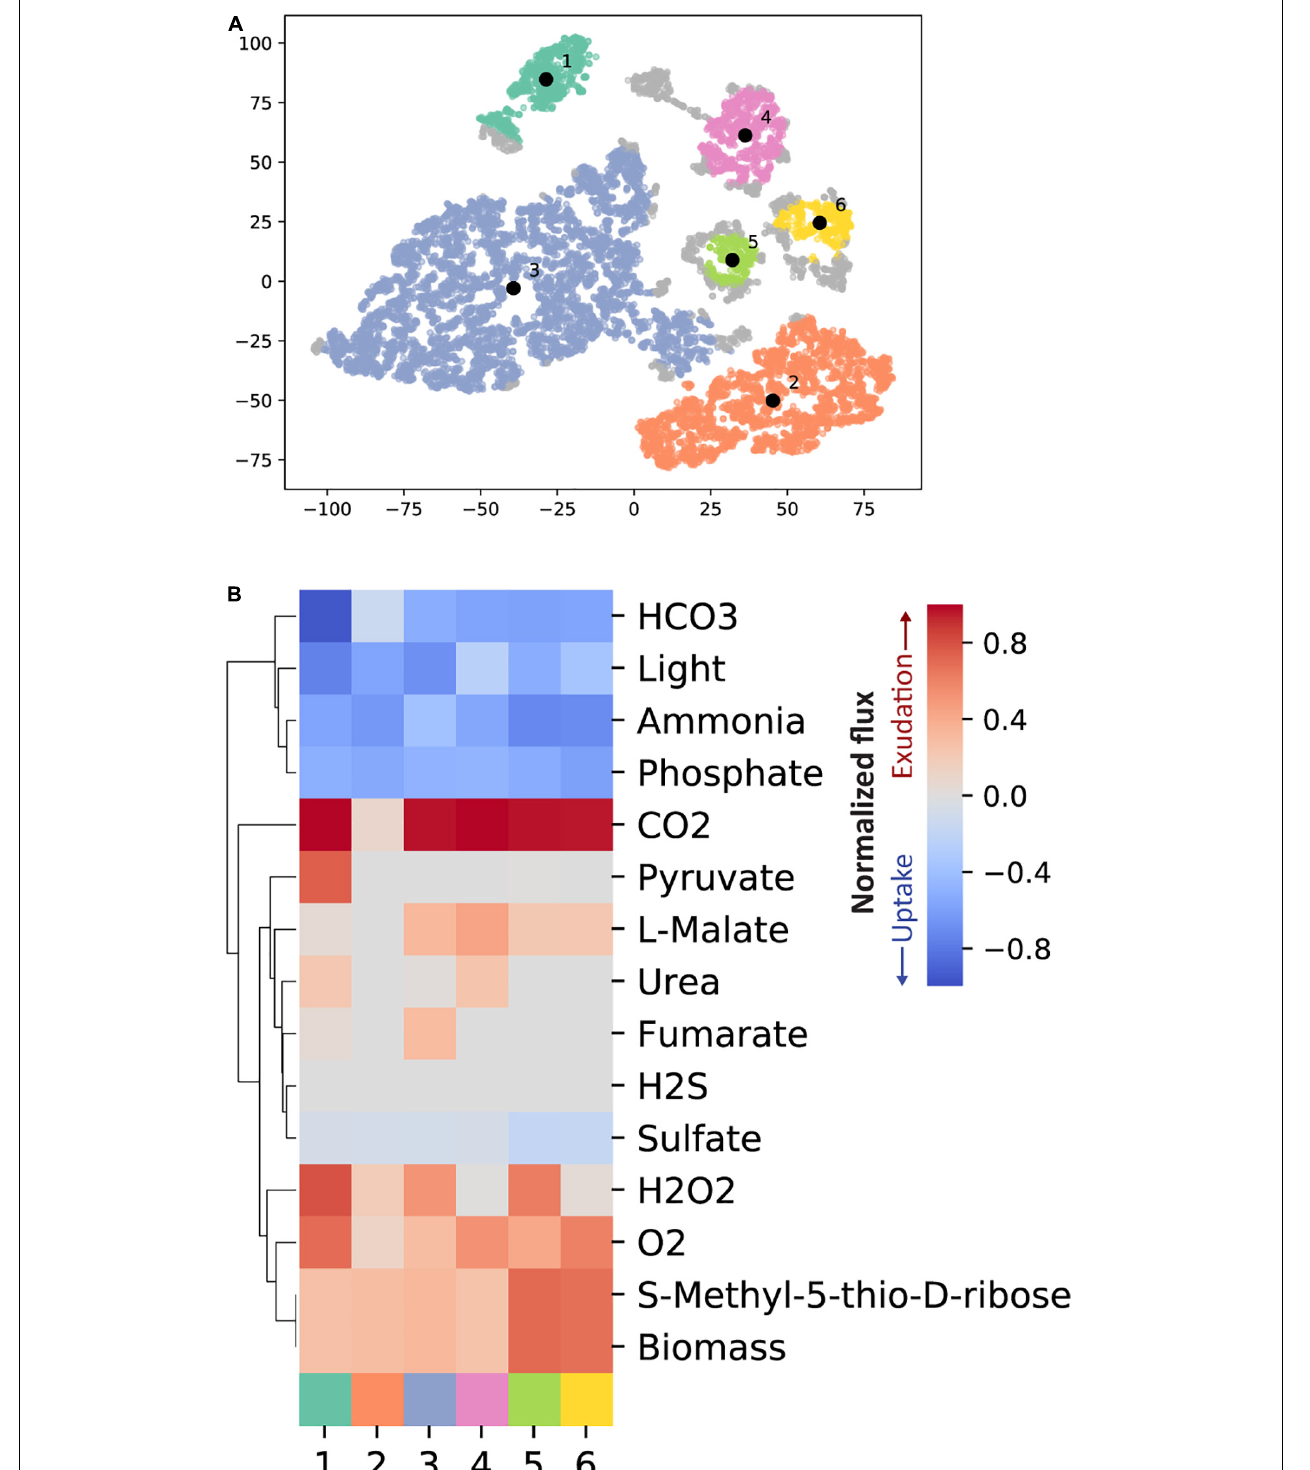
FIGURE 4 | T-SNE clustering identifies typical phenotypes from the pFBA results from the random samples. (A) The random samples are reduced into two dimensions with t-SNE. We have subsequently used HDBSCAN to cluster the data. HDBSCAN identified six disjoint clusters which represent different phenotypes. (B) For each of the six clusters the mean uptake or exudation across all samples within the respective cluster is shown. Only exchange reactions with an absolute flux above 1e-3 mmol gDW − 1 h − 1 in any of the random samples are included.